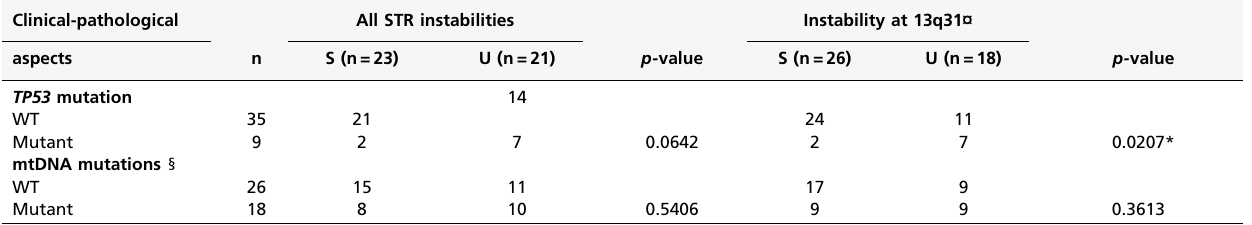
Table 2 - Association analysis of TP53 and mtDNA mutations with STR instabilities in invasive ductal carcinoma cases (n =